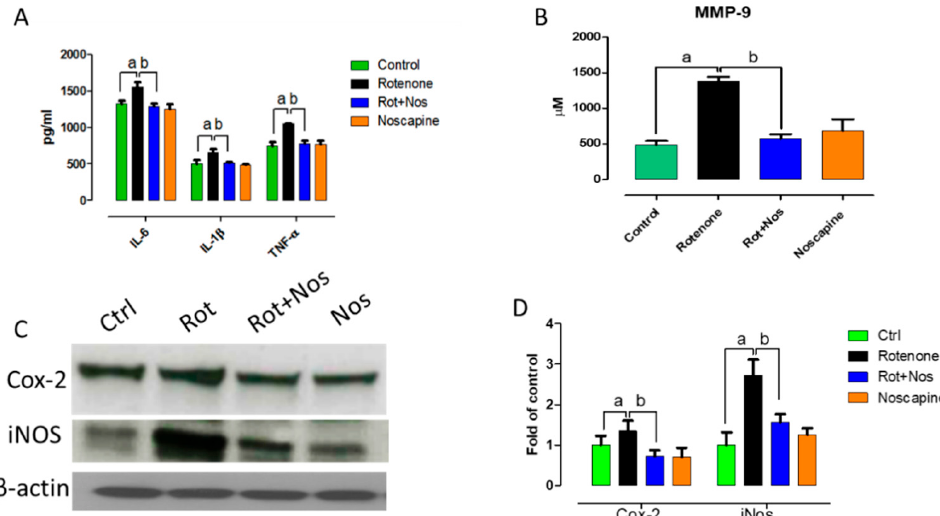
Figure 2. Noscapine inhibited MMP-9 production and modulated pro-inflammatory factors in experimental animals. Rotenone administration caused a significant increase in expression of pro-inflammatory cytokines ( A ) and enhanced production of MMP-9 ( B ). Western blotting analysis of midbrain protein samples probed with Cox-2 and iNOS ( C ). Quantitative analysis of western blots was performed using Image J and corresponding results were represented as bar diagram ( D ). However, noscapine treatment decreased expression and production of pro-inflammatory factors in rotenone-treated animals. Data are expressed as mean ± SEM. a p < 0.05 compared to control, b p < 0.05 compared to rotenone-treated group ( n = 5).